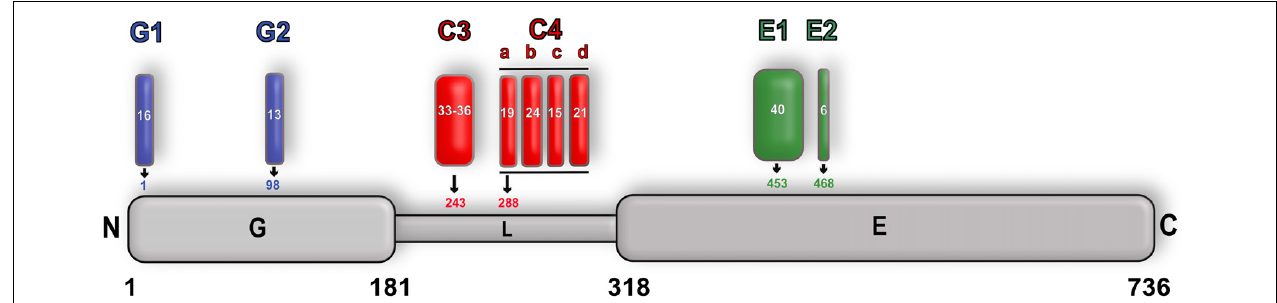
FIGURE 10 | Alternative splicing of gephyrin. Schematic representation of alternative splicing of gephyrin with GephG specific cassettes colored in blue, linker cassettes in red and E domain cassettes in green along with the length of the cassettes and also the insertion site is shown for each cassette. The full-length protein is numbered according to the P1 splice variant